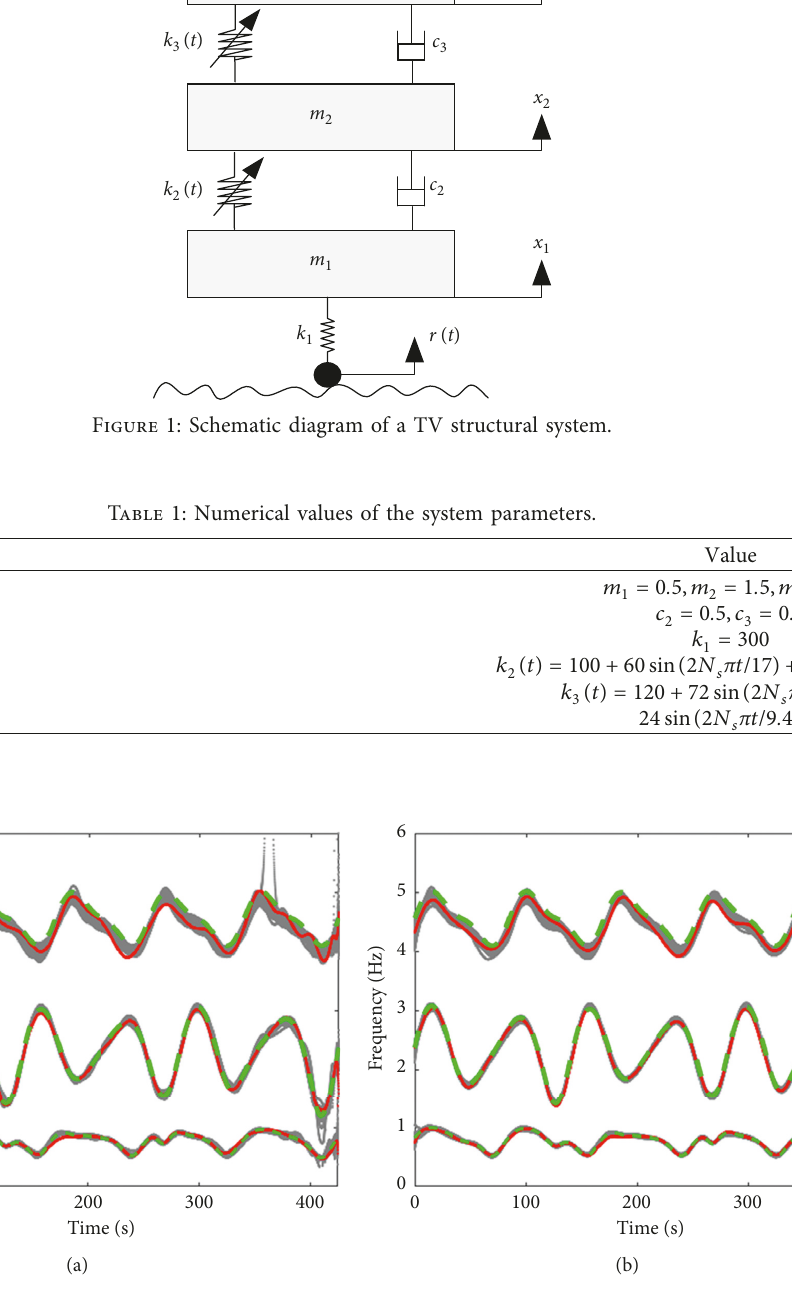
Figure 2: Natural frequency estimates by LS (a) and RR (b) for the TV numerical system with slow dynamic evolution (gray dots: natural frequency estimates from the 50 Monte Carlo tests; red dots: natural frequency estimates from the single test; green dashed lines: true values of natural frequencies).